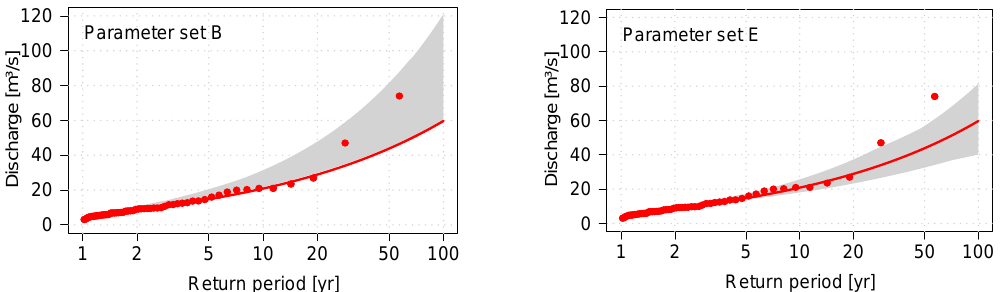
Fig. 11. Range of simulated design flows based on 20 model runs using 100yr of stochastic precipitation data representing the 90%- confidence interval against observed peak flows for the Silberhütte catchment for different parameter sets.